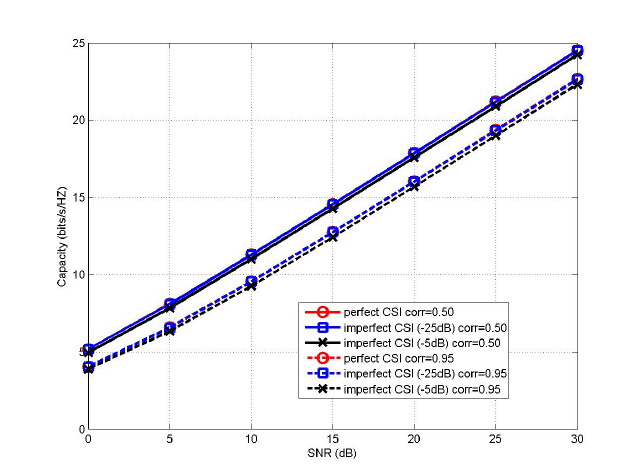
Figure 5. Channel capacity performance comparison between the proposed MLCNN in imperfect CSI and perfect CSI for ( 8,8;2,8 ) MIMO IoT system under correlation coefficients of corr = 0.50 and 0.95.